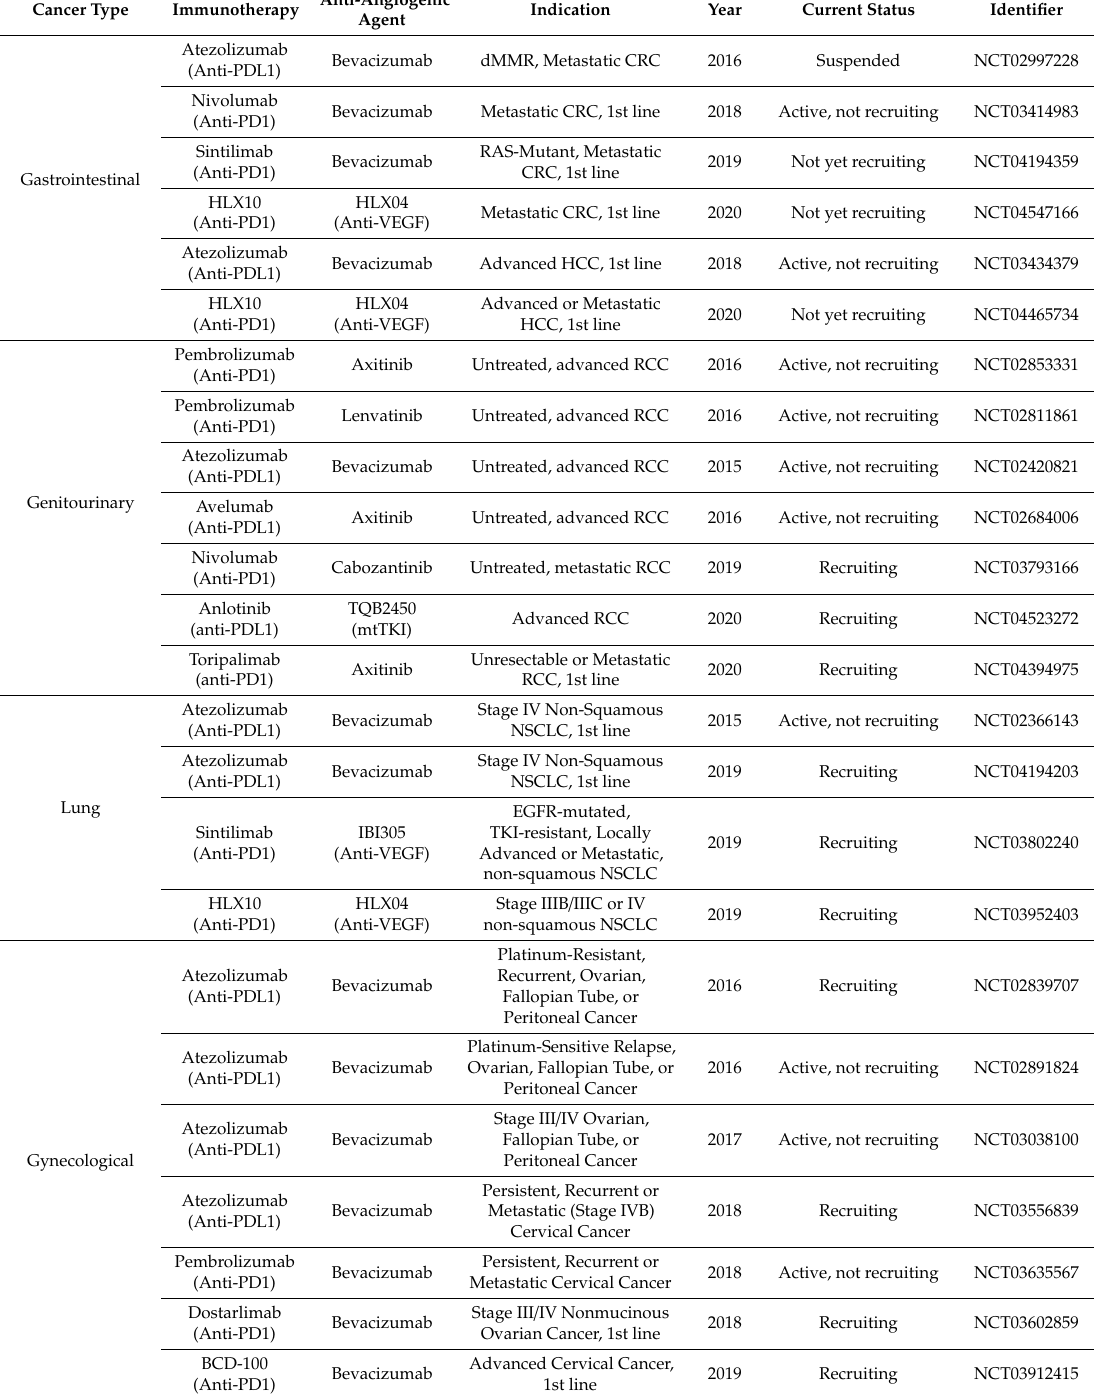
Table 3. Phase III studies of immune-checkpoint inhibitors with anti-angiogenic